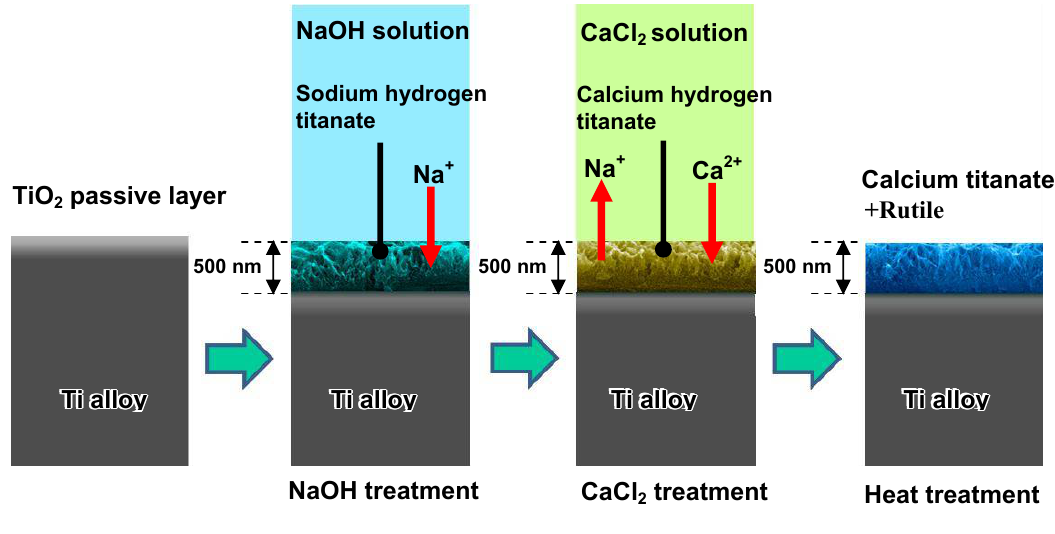
Figure 15. Structural changes of surface of Ti-15Zr-4Nb-4Ta alloy subjected by NaOH, and heat treatments. CaCl 2